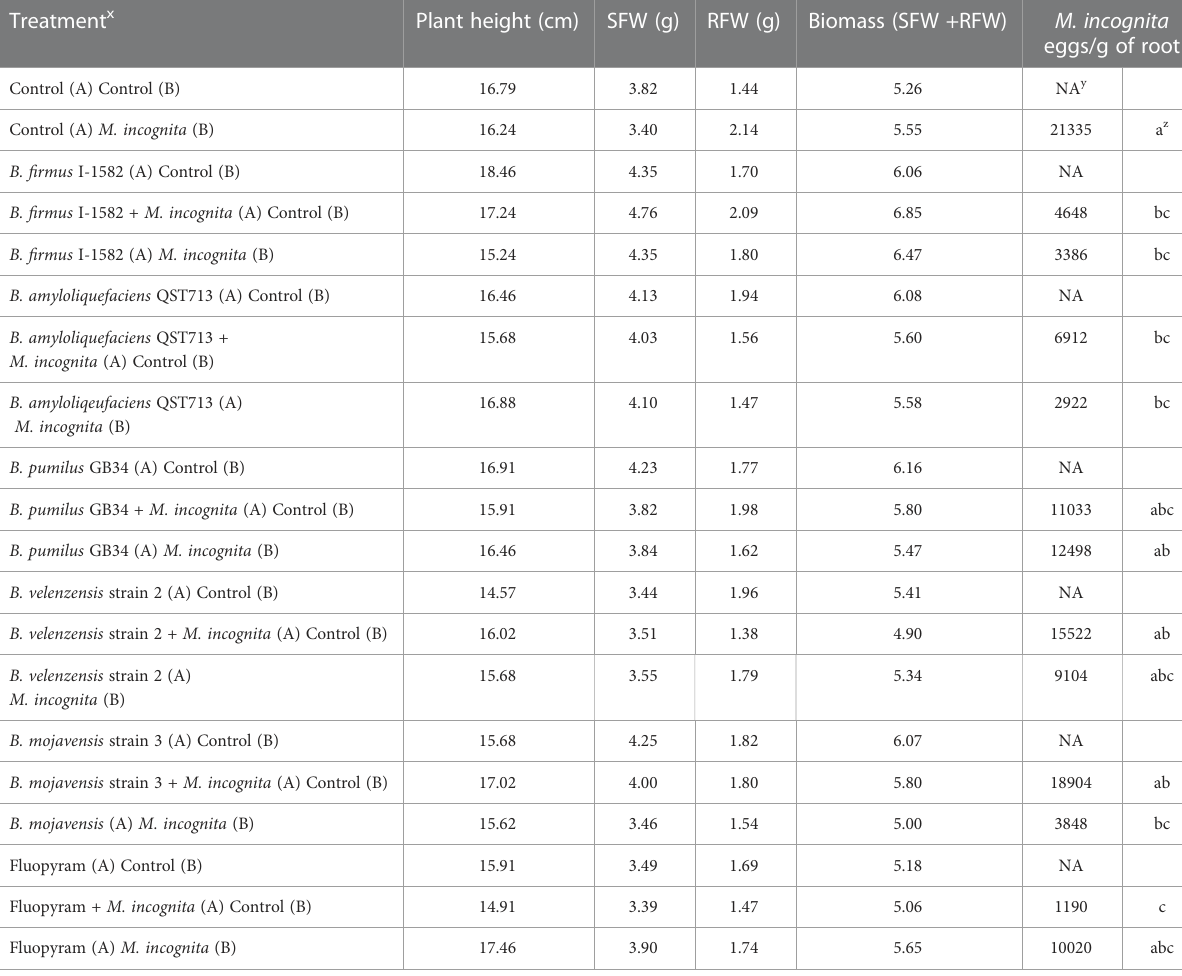
TABLE 4 Split root assay to measure the effect of the Bacillus spp. on Meloidogyne incognita on cotton as measured by plant height, shoot fresh weight (SFW), root fresh weight (RFW), biomass and M. incognita eggs/ gram of root 30 days after inoculation w . Treatment